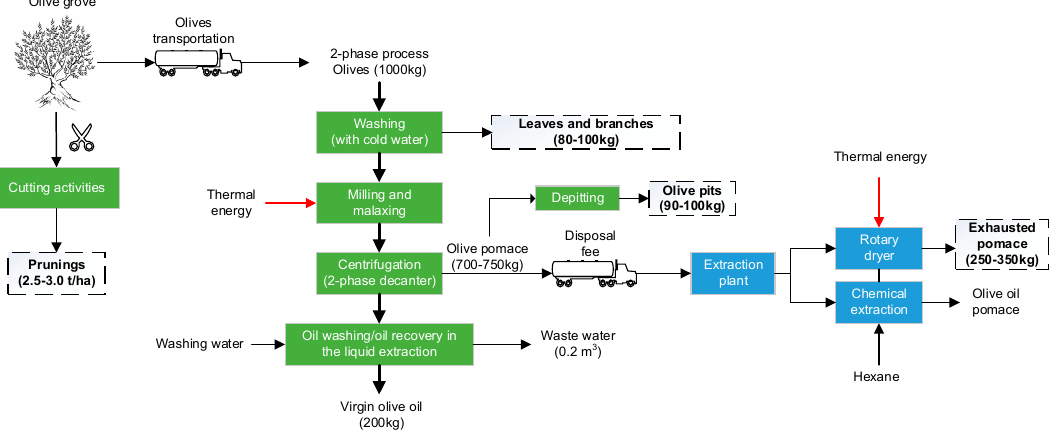
Figure 1. By-products during the olive oil industry value chain (Spanish 2-phase extraction process). Olive leaves and small branches or twigs are also considered an olive oil industry waste.